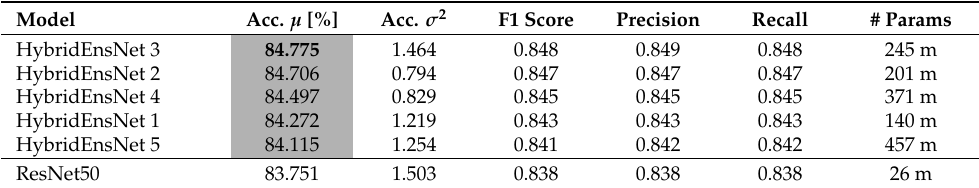
Table 5. Performance of the hybrid ensemble models applied with corresponding number of parame- ters.